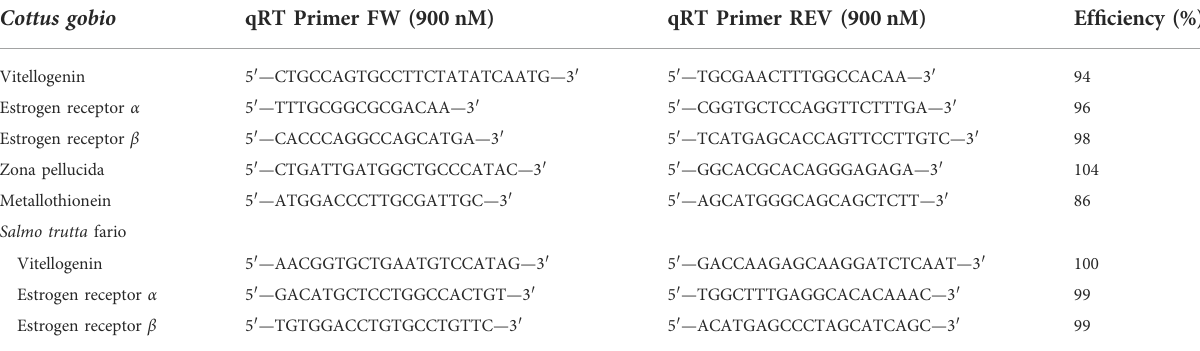
TABLE 1 Used quantitative real time PCR primers and PCR ef fi ciencies for Cottus gobio and Salmo trutta fario. qRT PCR primers for vitellogenin, estrogen receptor α - and β from S. trutta fario were adopted from Körner et al. (2008). Cottus